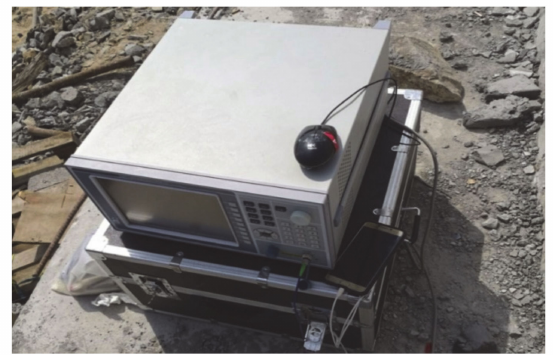
Figure 2. BOTDR demodulator.